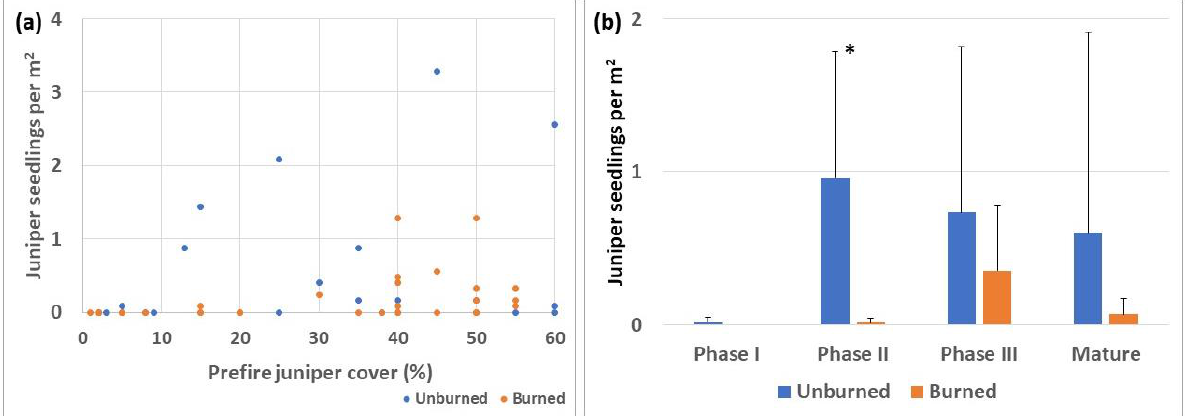
Figure 7. Juniper seedlings per m 2 versus pre-fire percentage juniper cover for unburned and burned plots ( a ) and by woodland development phase ( b ). Error bars represent standard deviation, and significance ( p < 0.05) is denoted with a star (*). Both graphs reflect data from sampling period 2 (12–13 years post-fire); no juniper seedlings were observed along the transects on burned plots in sampling period 1.